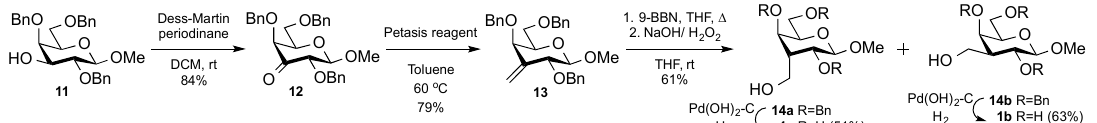
Figure 1. Structures of the tested compounds 1–8 and reference compound 32 .